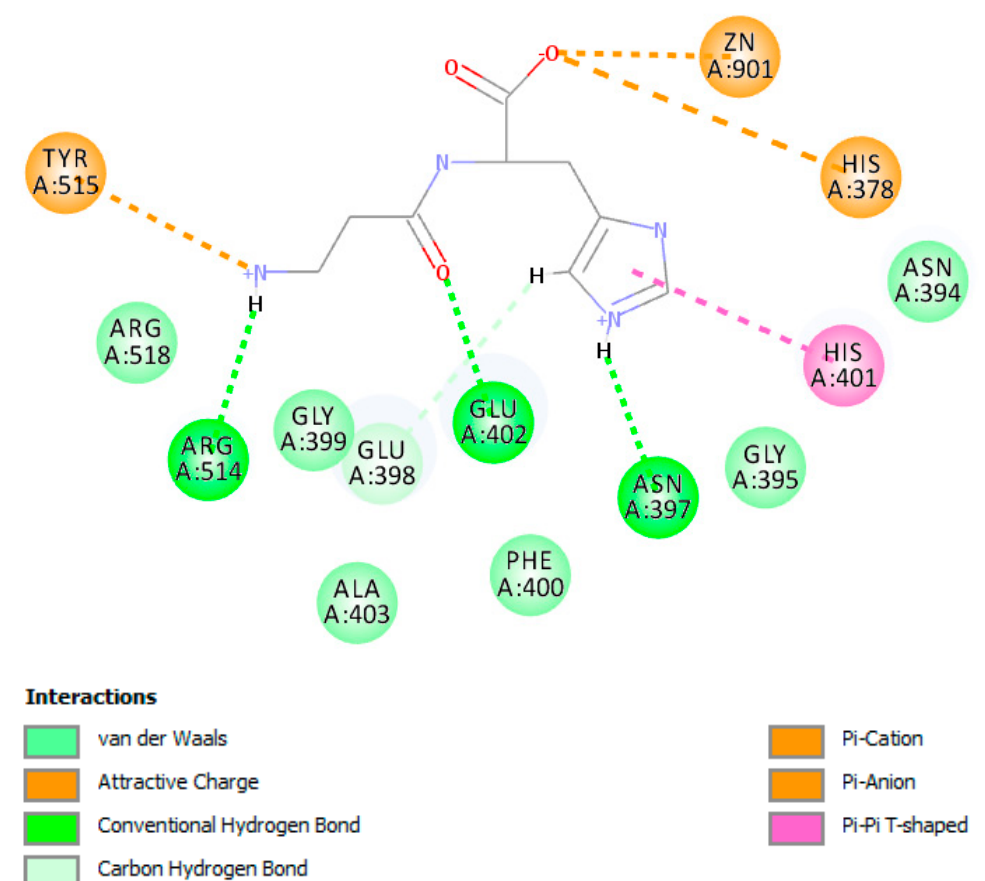
Figure 9. 2D diagram shows the docked pose of the highest score carnosine within the active site of ACE2. of